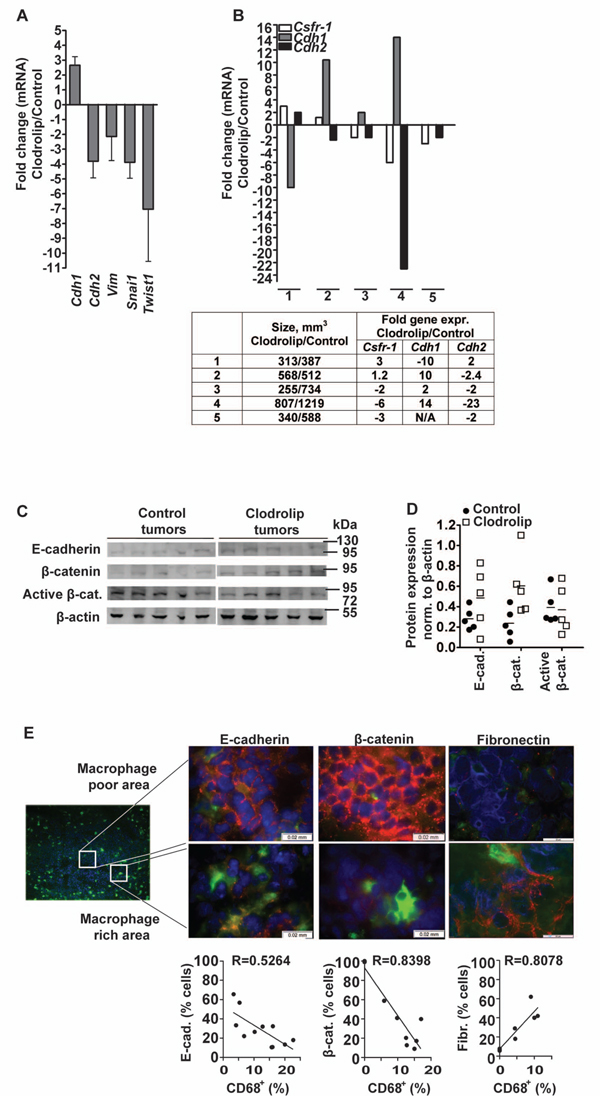
Macrophage depletion correlates with reduced mesenchymal marker expression in F9-teratocarcinomas. (A) Relative gene expression (mRNA levels) of E-cadherin (cdh1), N-cadherin (cdh2), vimentin (vim), Snail and Twist in clodrolip treated vs. control tumors; n = 5-6, bars: means ± SEM. The tumors analyzed in this experiment were collected from two independent depletion experiments. Non-responders were excluded. (B) Relative gene expression (mRNA levels) of Csfr-1, E-cadherin (cdh1) and N-cadherin (cdh2) in size matched clodrolip treated vs. control tumors; n = 5-6, bars: means ± SEM. The tumors analyzed in this figure were collected from a single depletion experiment. The table shows individual volumes and gene expression levels of paired treated vs. control tumors. (C) Western blot analysis of E-cadherin, total β-catenin and active β-catenin expression in control and clodrolip treated tumors; n = 5. (D) Quantification of the western blot is shown in Figure C. (E) Immunofluorescence analysis of CD68+ macrophages (green), E-cadherin (red, left panel), β-catenin (red, mid panel) and fibronectin (red, right panel) in a macrophage poor area (upper panel, magnification 100×) and in a macrophage rich area (lower panel, magnification 100×) in a control tumor section (left picture, magnification 10×). The nuclei were stained with DAPI (blue). Scale bar = 0.02 mm. The graphs indicate correlations between CD68+ density and expression of the annotated EMT markers. Each data point represents analysis of one tumor section; n = 3-5/group. The linear regression coefficient R is indicated.